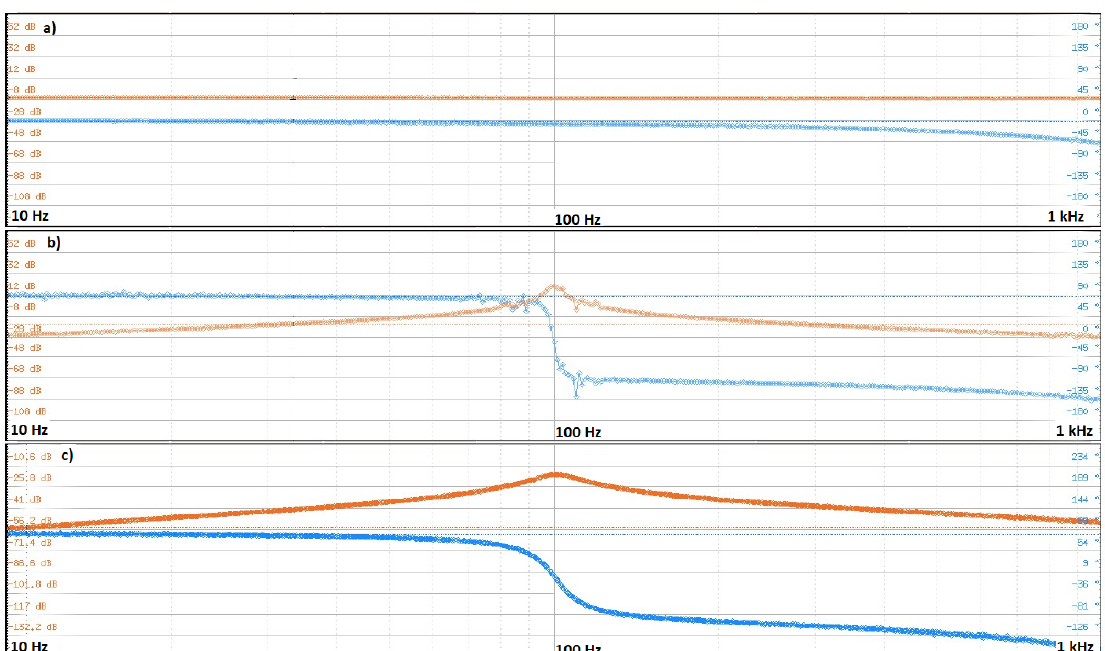
Figure 10. Frequency domain analysis of the dual active bridge converter in open loop ( a ), the PR controller ( b ), and the PR-driven dual active bridge converter in closed loop ( c ).